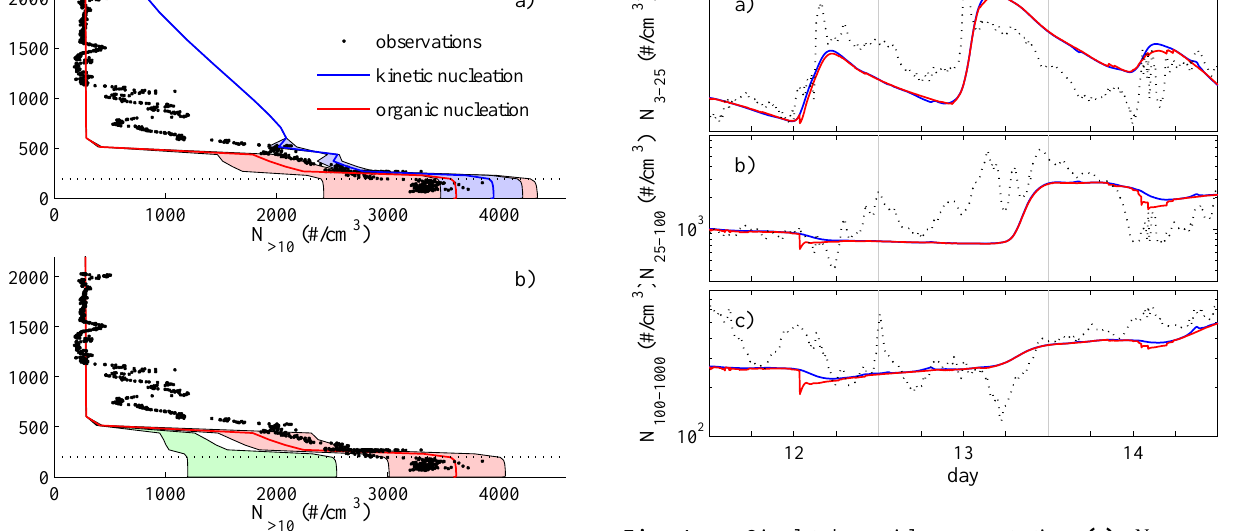
Fig. 4. Simulated particle concentration (a) N 3 − 25nm , (b) N 25 − 100nm and (c) N 100 − 1000nm at the top of the ABL (red curve) and at the surface (blue curve). The observed aerosol con- centration at the surface is shown by black dotted